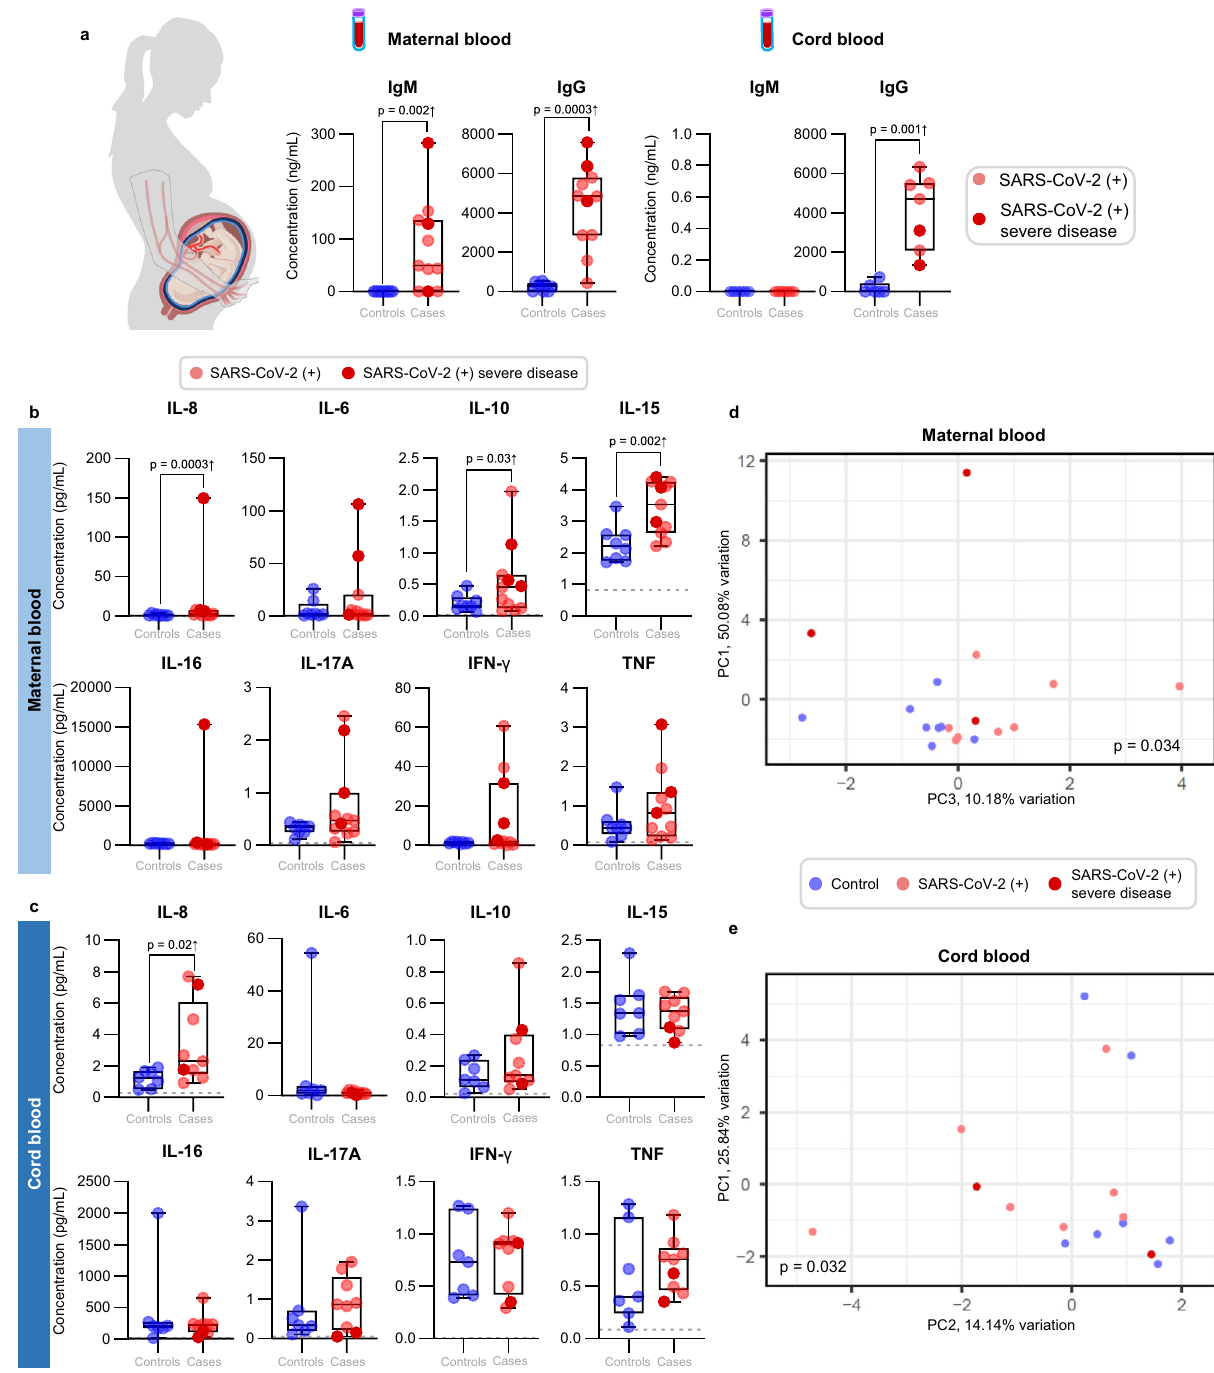
Fig. 1 Serological and cytokine responses in maternal and cord blood of women with SARS-CoV-2 infection and their neonates. a Serum concentrations of IgM and IgG in the maternal blood [ n = 9 control, 11 SARS-CoV-2 ( + )] (left panel) and cord blood [ n = 6 control, 7 SARS-CoV-2 ( + )] (right panel). Data are shown as boxplots where midlines indicate medians, boxes indicate interquartile range and whiskers indicate minimum/maximum range. Differences between groups were evaluated by two-sided Mann – Whitney U -tests. p -values < 0.05 were used to denote a signi fi cant result. Plasma concentrations of IL-8, IL-6, IL-10, IL-15, IL-16, IL-17A, IFN- γ , and TNF in b maternal blood [ n = 8 control, 11 SARS-CoV-2( + )] and c cord blood [ n = 7 control, 9 SARS-CoV-2( + )]. Data are shown as boxplots where midlines indicate medians, boxes indicate interquartile range and whiskers indicate minimum/maximum range. Gray dotted lines indicate the lower limit of detection. Differences in cytokine concentrations between groups were evaluated by linear mixed-effects models with adjustment for covariates. Scatter plots of two principal components (PC1 and PC3 or PC1 and PC2) from plasma cytokine concentrations in the d maternal blood [ n = 8 control, 11 SARS-CoV-2( + )] and e cord blood [ n = 7 control, 9 SARS-CoV-2( + )]. The association between principal components (PC1, PC2, and PC3 jointly for maternal blood and PC2 for cord blood) and SARS-CoV-2 ( + ) status was assessed by logistic regression. Blue dots indicate control women, light red dots indicate SARS-CoV-2 ( + ) women, and dark red dots indicate women with severe COVID-19. Signi fi cant differences are based on p <